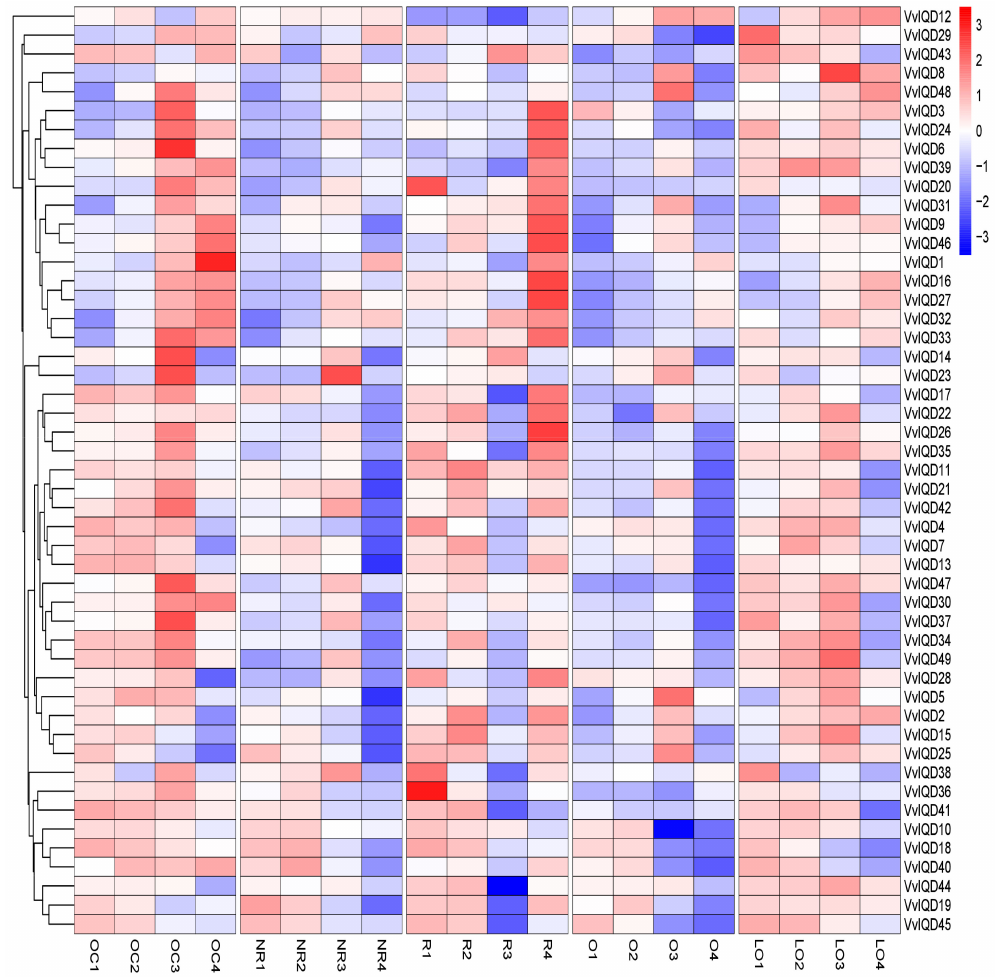
Figure 4. Expression profiles of the VvIQDs genes in di ff erent grapevine cultivars with distinct shape at di ff erent developmental stages. Where OC shows oblate circle; NR, nearly round; R, round; O, oval; and LO, long oval. The numbering (1–4) of each shape indicates V. vinifera di ff erent developmental stages (i.e., 20daf, 50daf, 80daf, and